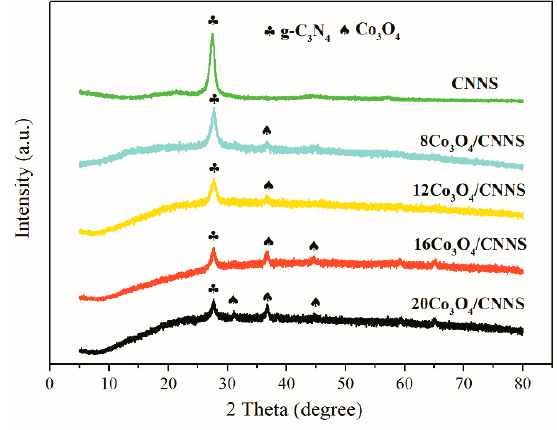
Figure 4. XRD patterns of pure and Co 3 O 4 -modified CNNS.